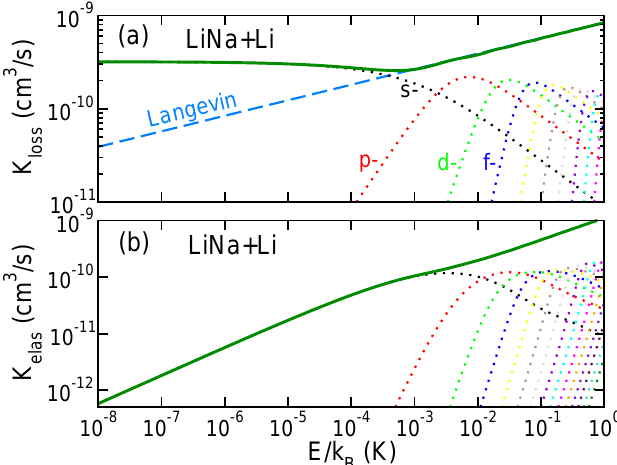
Figure 2. LiNa + Li total reaction (panel ( a )) and elastic (panel ( b )) rate coefficient for the universal model as a function of collision energy. The LiNa dimer is prepared in its ro-vibrational X 1 Σ + ground state. Li 2 product molecules are energetically-allowed ro-vibrational states of the X 1 Σ + g potential. Dotted lines correspond to the individual partial-wave contributions to the rate coefficients. In panel ( a ) the reaction rate coefficient based on the Langevin model is shown by the long-dashed blue line. Finally, k B is the Boltzmann constant.